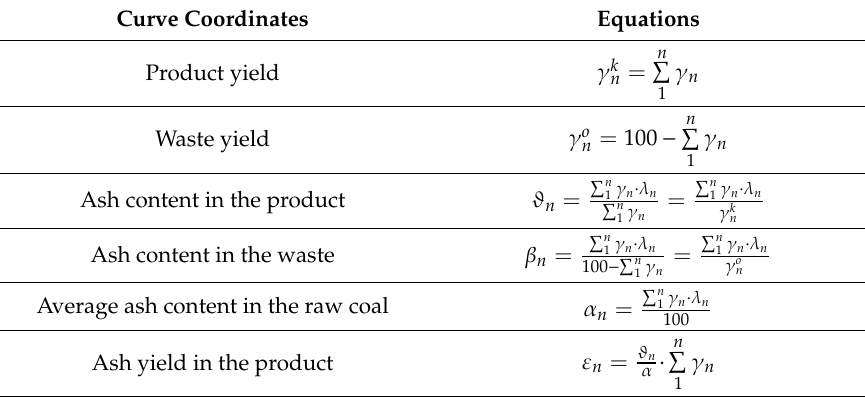
Table 1. The washability curves equations [56].